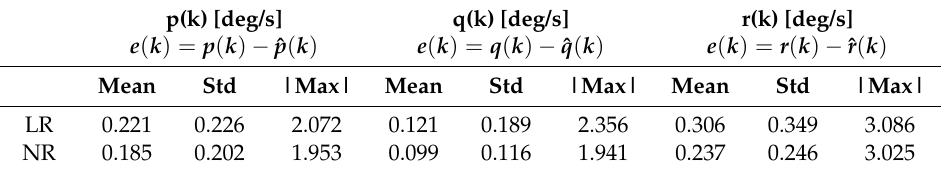
Table 2. Performance for Linear and Nonlinear models in validation